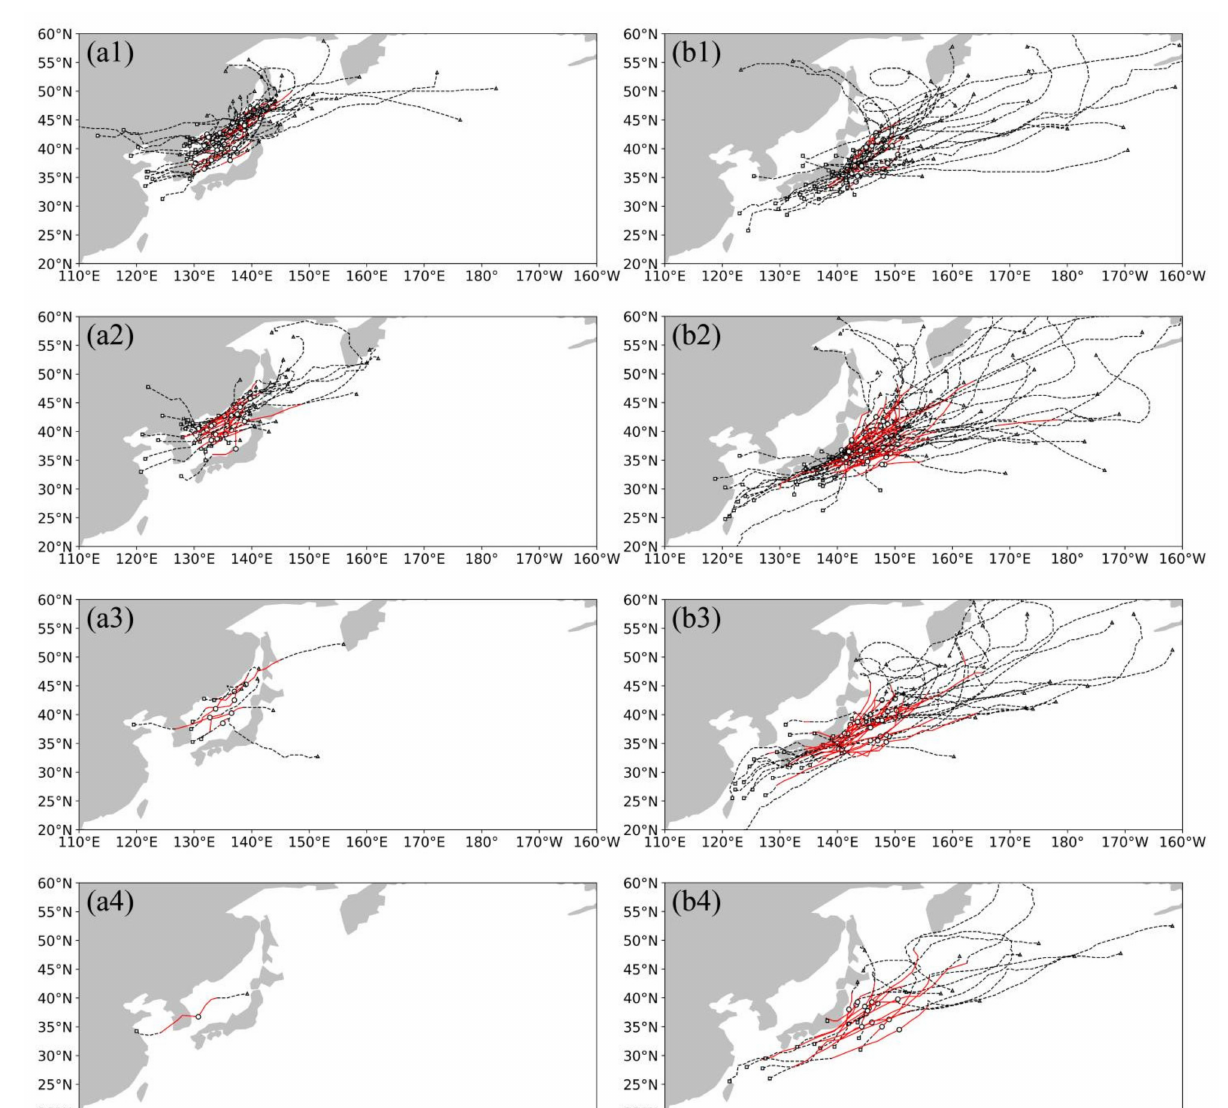
Figure 6. Moving tracks of ( a1 , b1 ) weak, ( a2 , b2 ) moderate, ( a3 , b3 ) strong and ( a4 , b4 ) super ECs over the Japan Sea (left column) and Kuroshio/Kuroshio Extension (right column). “ (cid:3) ” is the EC center at the formation moment, “ ◦ ” is the EC center at the maximum-deepening-rate moment, “ ∆ ” is the EC center at the ending moment. The dashed line indicates the track with a deepening rate smaller than 1 MBer, while the red-solid line indicates the track with a deepening rate larger than or equal to 1